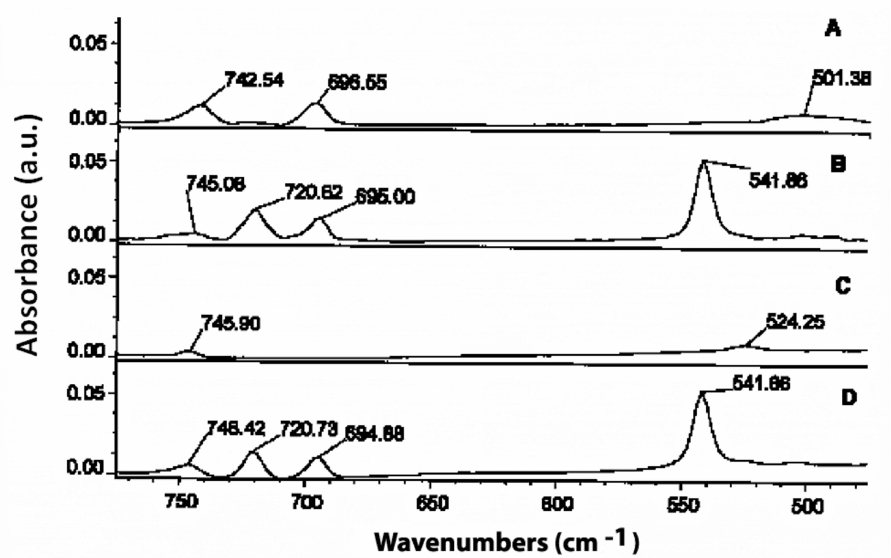
Figure 7. Differential spectra of TPP/hexanol ( A ), TPPO/hexanol ( B ), TBHP ( C ), and reacted TBHP and TPP/hexanol ( D ) in canola oil over the spectral range of 775–475 cm − 1 . Spectrum D of TBHP shows the presence of the band at 542 cm − 1 due to TPPO formed by the reaction of TPP with TBHP in canola oil. Adopted with permission from [36]. Copyright 1997,